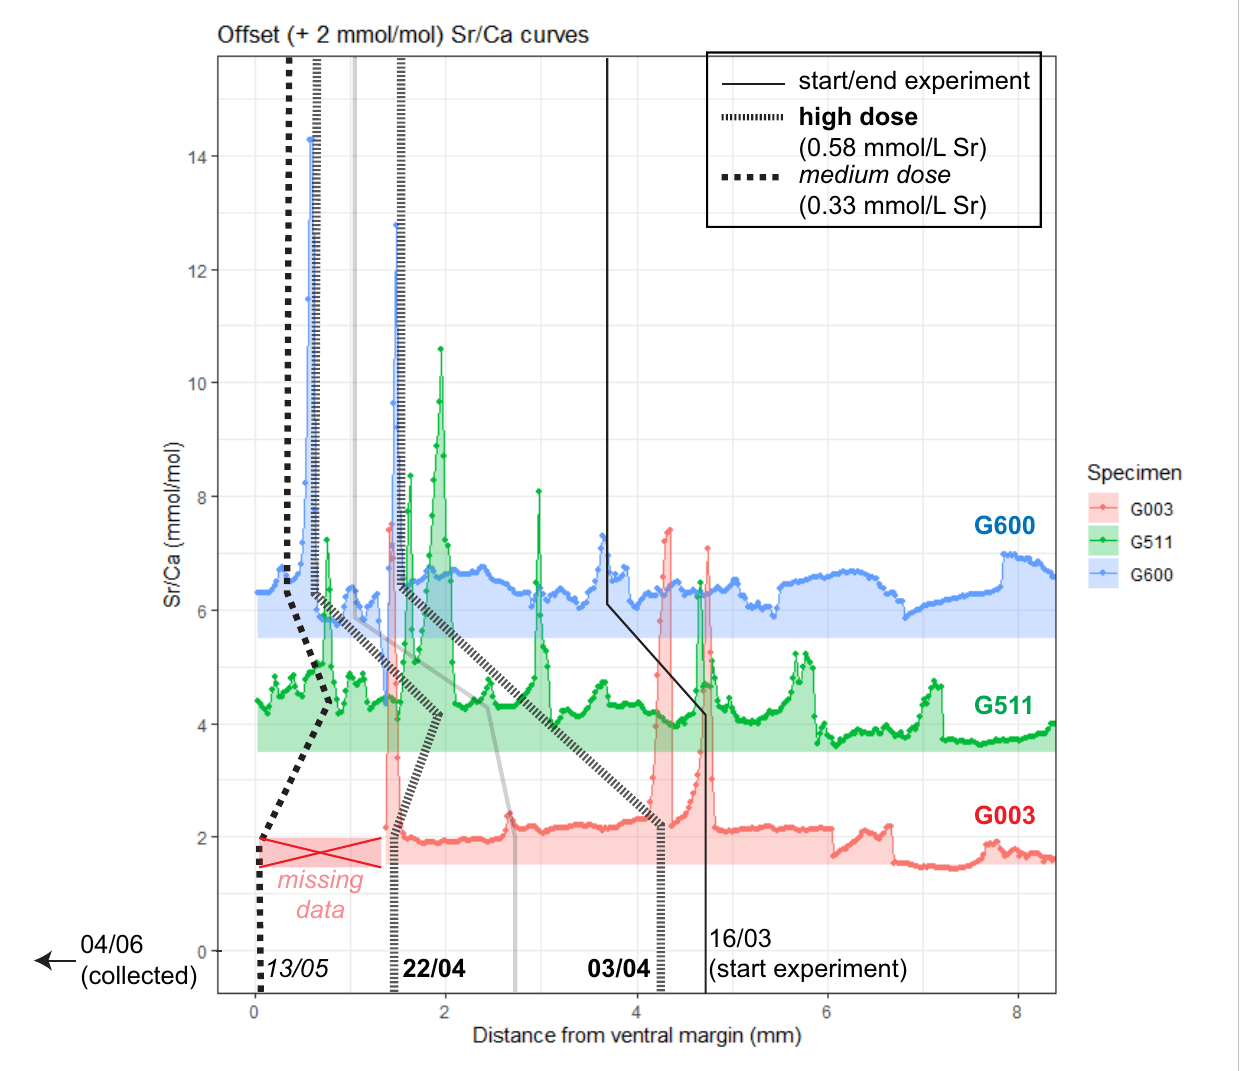
FIGURE 4 m XRF Sr/Ca records through aragonitic cockle specimens G003, G511 and G600. Records from subsequent specimens are offset by 2 mmol/mol from each other, with the lowest record showing original Sr/Ca values. Lines connecting records vertically mark the beginning of the experimental period as recorded in the shells and the location of Sr peaks, with numbers at the bottom listing the dates (dd/mm) of the events. Doses of Sr peaks are indicated with different lengths of line dashes (see legend in top right corner: high dose; 7.7-fold increase in [Sr] w ; administered at 03/04 and 22/ 04; medium dose; 4.4-fold increase in [Sr] w ; administered at 13/05). Distance on horizontal axis is measured in scan direction (growth direction from right to left). Note that due to issues with the cross-section surface, data from the fi rst part of the record through specimen G003 was